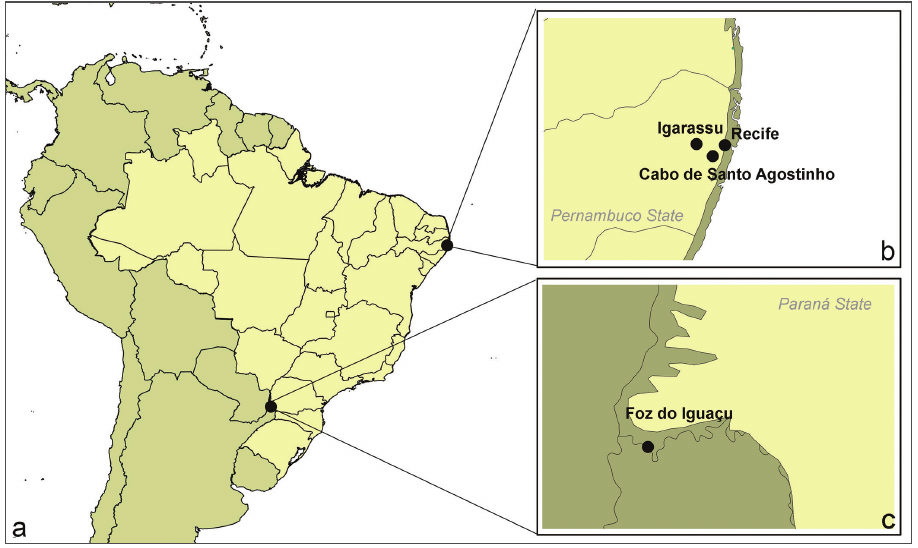
Figure 1. a map of Brazil showing collection sites in northeastern and southern Brazil b Tropidacris collaris c Tropidacris cristata grandis